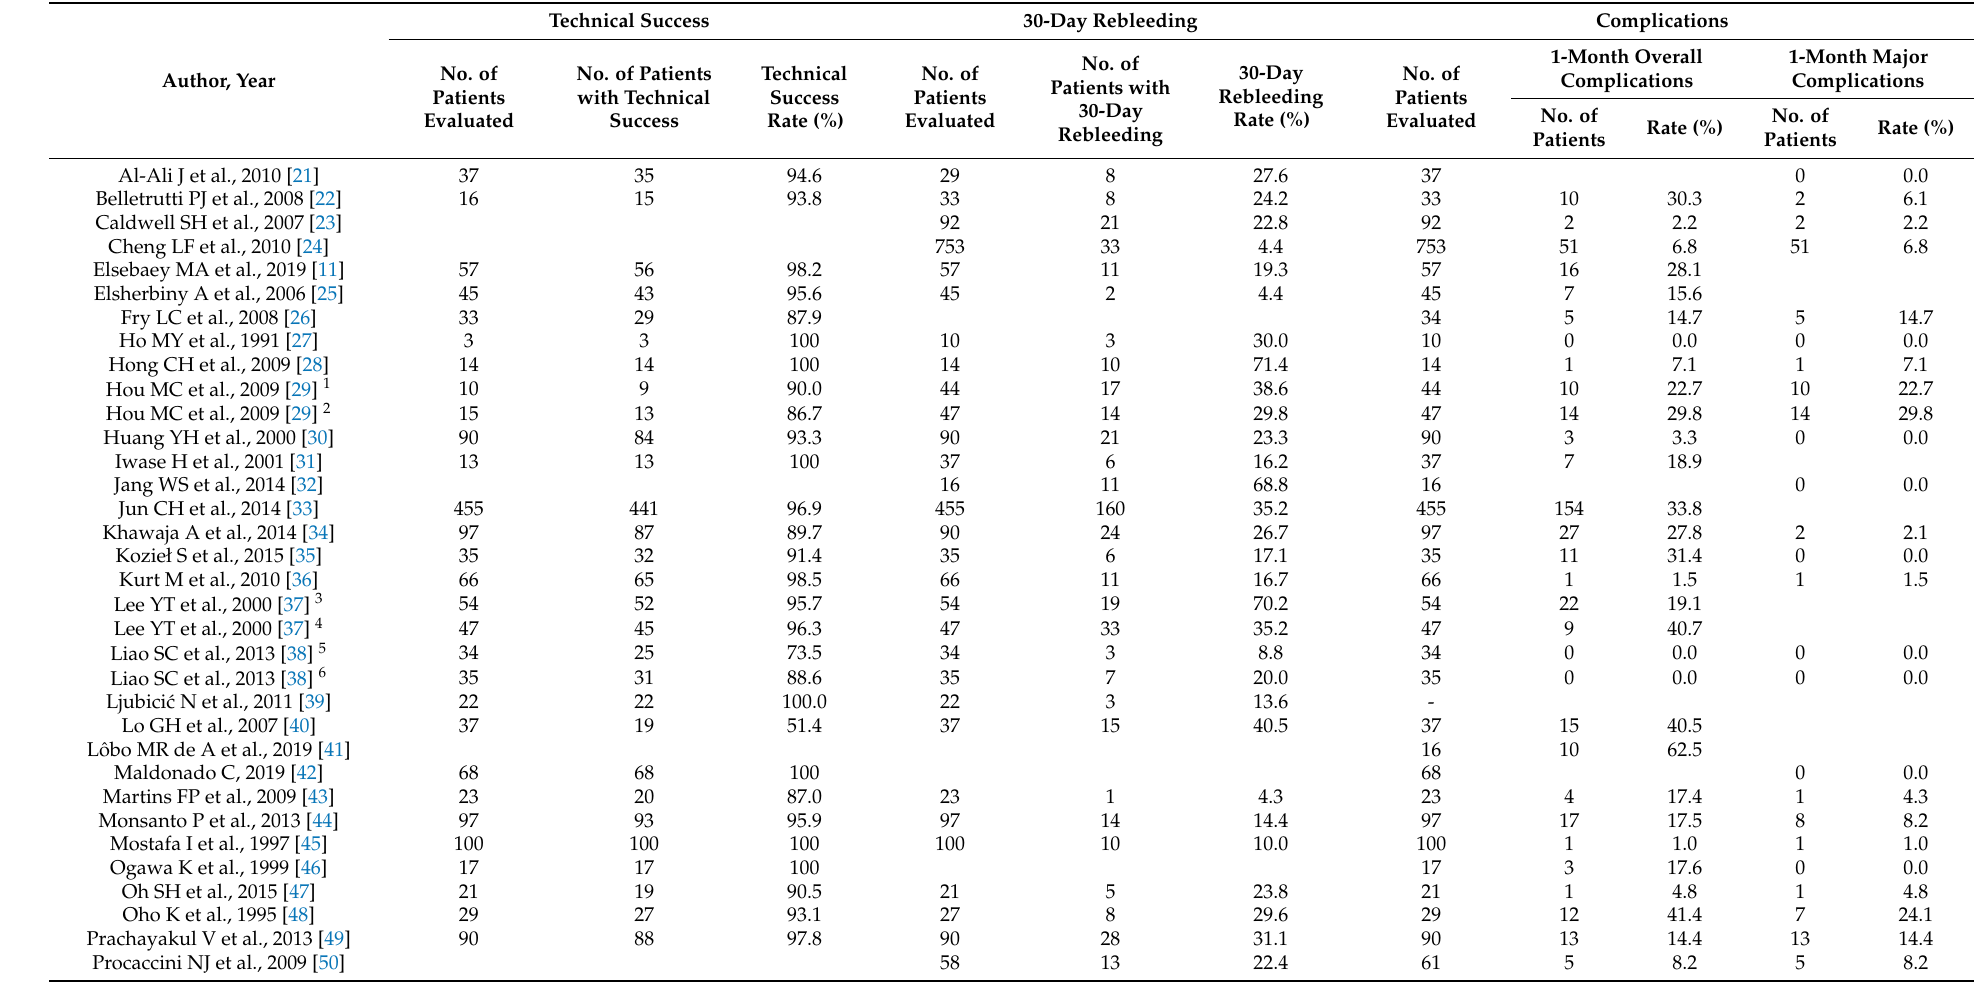
Table 2. Technical success, 30-day rebleeding and complications rates by study in patients treated with NBCA-Lipiodol ® mixture for variceal gastrointestinal